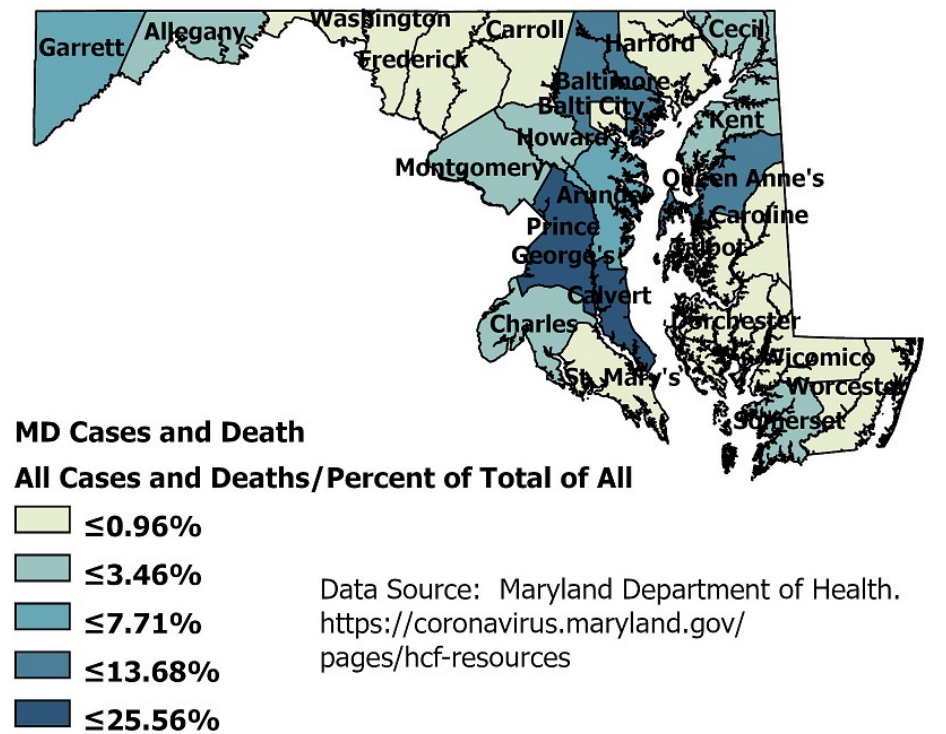
Figure 3. Counties in Maryland showing nursing home COVID-19 percentage of cases and deaths.